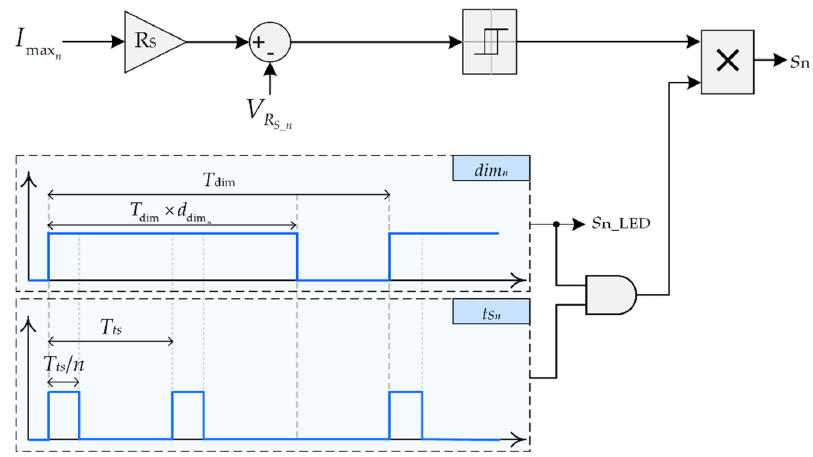
Figure 5. Converter control architecture.